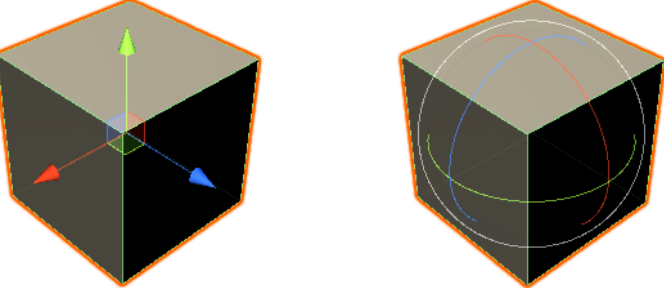
Figure 1. Unity transform gizmos. Position and rotation, respectively.